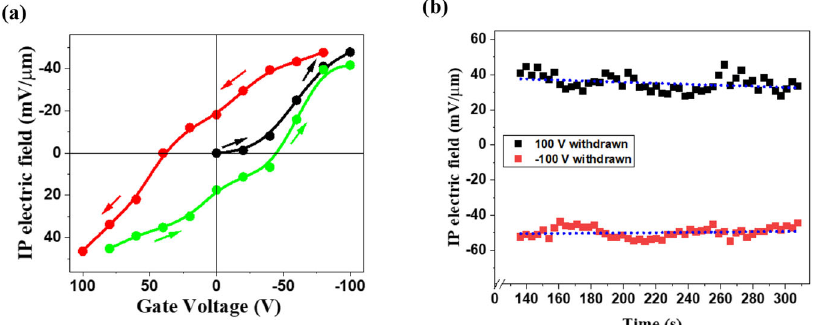
Fig. 4 Polarization hysteresis. a IP electric fi eld across the α -In 2 Se 3 channel as a function of withdrawn gate voltage. The connected black dots denote electric fi elds for withdrawn gate voltage from 0 to − 100 V, the connected red dots denote electric fi elds for withdrawn gate voltage from − 80 to 100 V and the connected green dots indicate electric fi elds for withdrawn gate voltage from 80 to − 100 V. The direction of the arrows indicates the direction of progression of the scan. b Temporal remanence of the IP electric fi eld after the withdrawal of gate bias. The dotted blue lines show the general trend of the evolution of the electric fi eld with